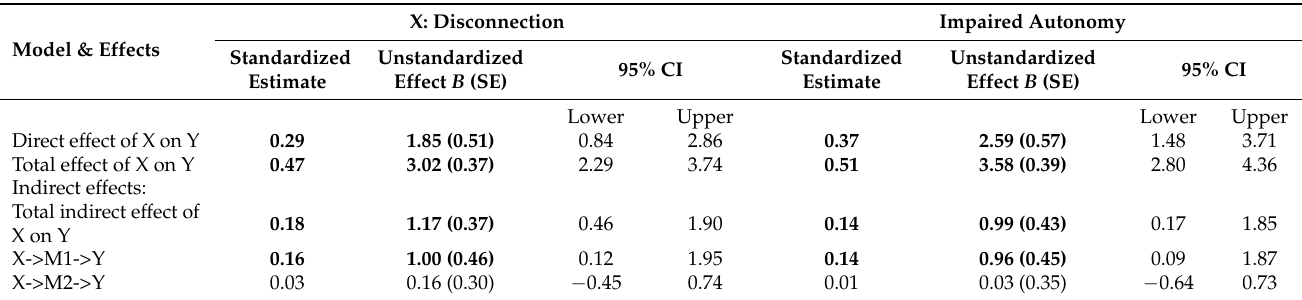
Table 5. Two parallel bootstrapped mediation models testing whether the relationship between either Disconnection domain (X) of early maladaptive schemas (EMS) or Impaired Autonomy domain (X) of EMS, and self-stigma (Y) is mediated by Psychological Flexibility (M1) and/or Self-compassion